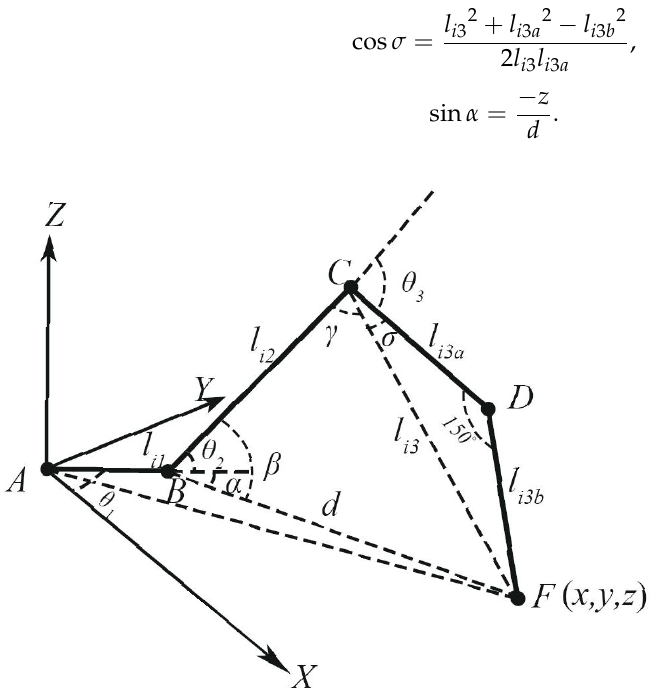
Figure 5. The leg’s diagram for the solution of inverse